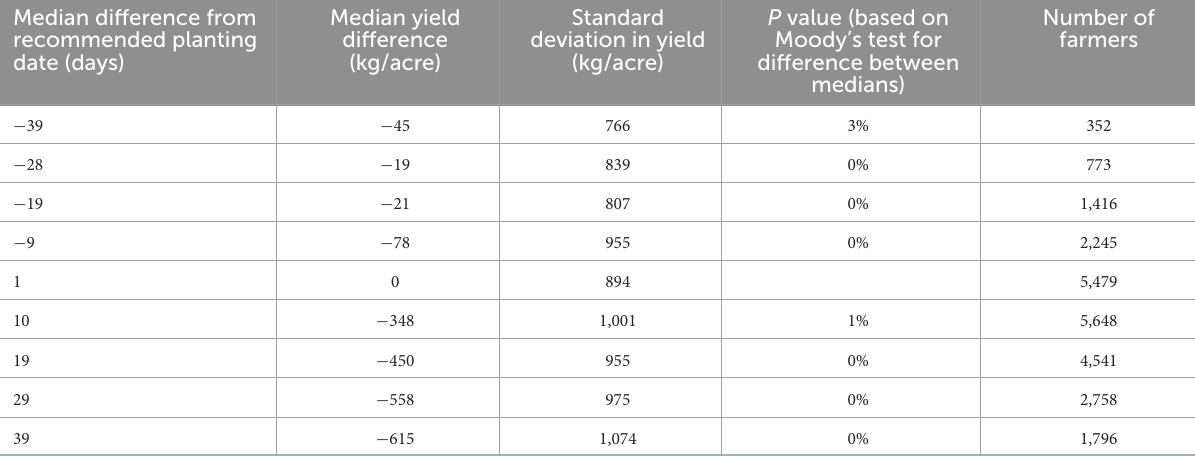
FIGURE7 Box and whiskers plot for yield difference between the median for compliant farmers (in a given season and country) and the yield achieved. The categories are: early ( > 10 days before recommendation); compliant (within 10 days of recommendation) and late ( > 10 days after the recommendation).